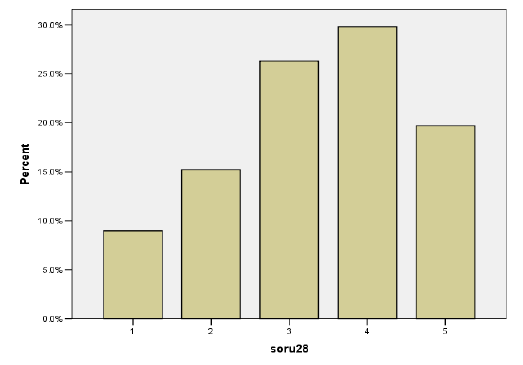
Figure 15. Should accounting education value ethical concepts more?